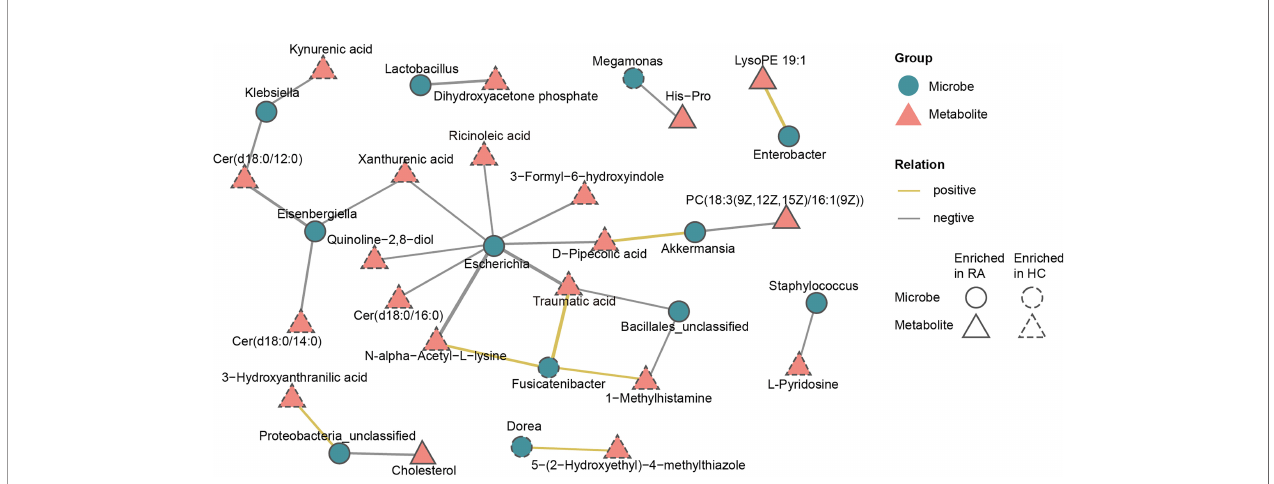
FIGURE 7 | Multiomics approach revealed microbiota-metabolite interactions in RA patients. The co-occurrence network graph showed the main microbiota- metabolite correlations (Spearman ’ s correlation analysis, r > 0.42, P < 0.05). Microbes were labeled with circles and metabolites with triangles. Solid or dashed borders indicated that the corresponding nodes were enriched in RA patients or healthy controls, respectively. Yellow connecting lines represent positive correlations between two nodes, while gray connecting lines represent negative correlations, and thicker lines indicate greater correlation